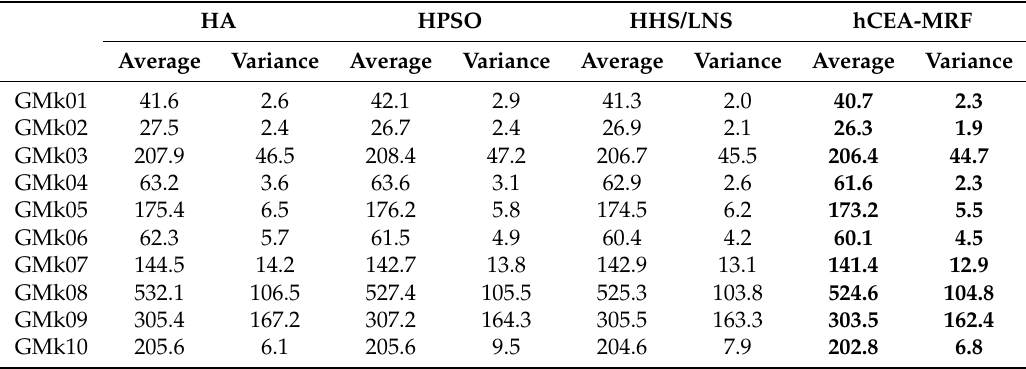
Table 5. The performance compared with the state-of-the-art for the generated instances by Gaussian distribution. HA HPSO HHS/LNS hCEA-MRF Average Variance Average Variance Average Variance Average